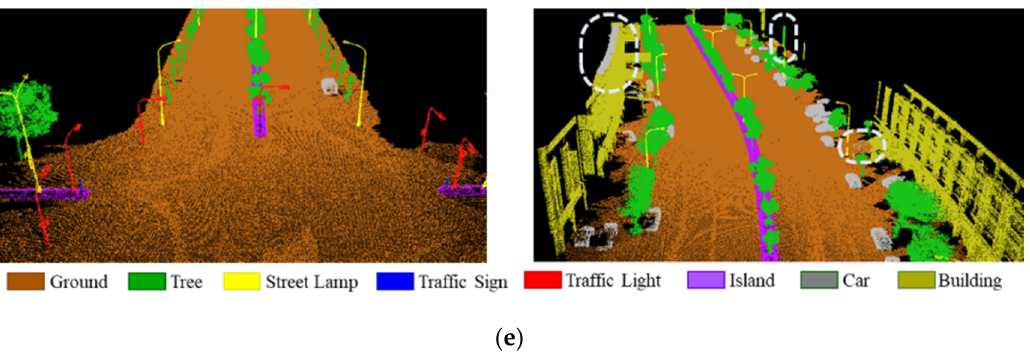
Figure 18. Classification results of RF and DL models on MLS point cloud with eight classes: ( a ) Labelled categories (ground truth); ( b ) Classification results of RF; ( c ) Classification results of PointNet(F); ( d ) Classification results of PointNet++; ( e ) Classification results of KPConv.